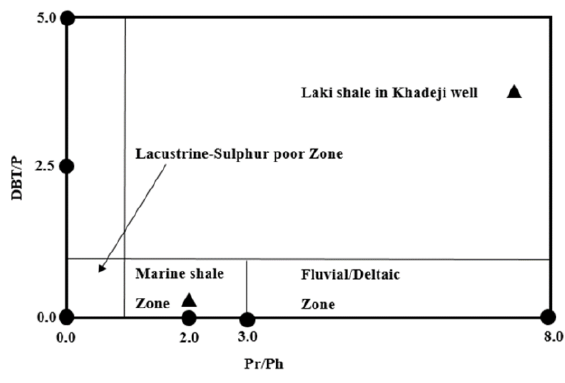
Figure 8: Cross plot of DBT/P vs. Pr/Ph showing depositional environment of Laki shale (boundaries after Hughes et al., 1995).